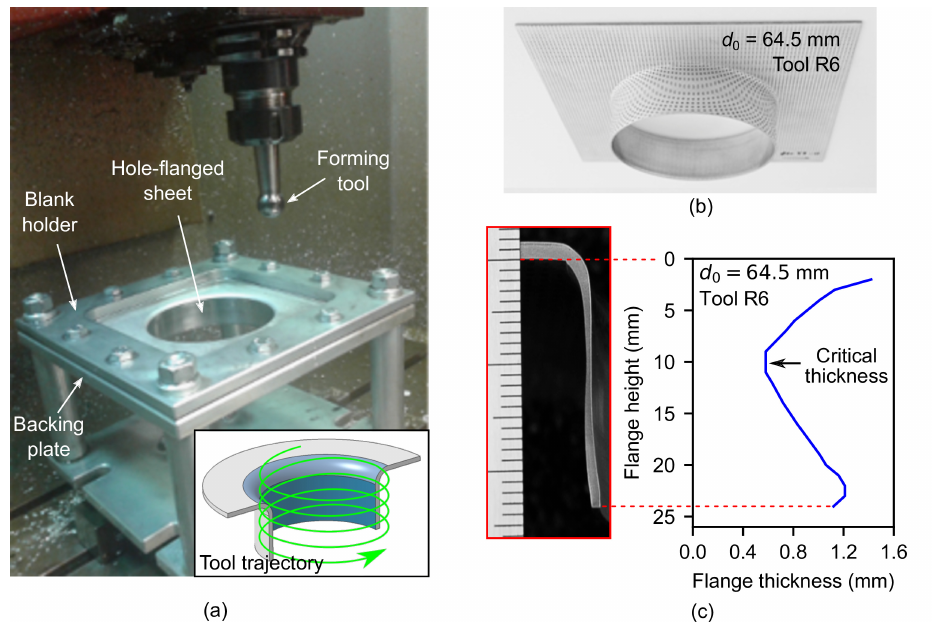
Figure 1. Hole-flanging by Single point incremental forming (SPIF) in a single stage of an AA7075-O sheet blank of 1.6-mm thickness: ( a ) experimental setup; ( b ) hole-flanged sheet part; and ( c ) thickness distribution along the